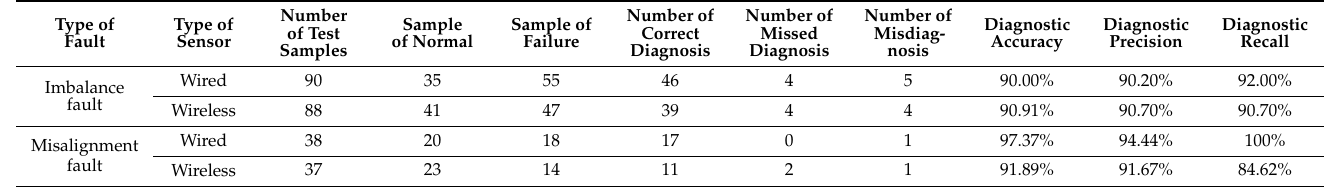
Table 6. Statistical records of tests for imbalance fault and misalignment